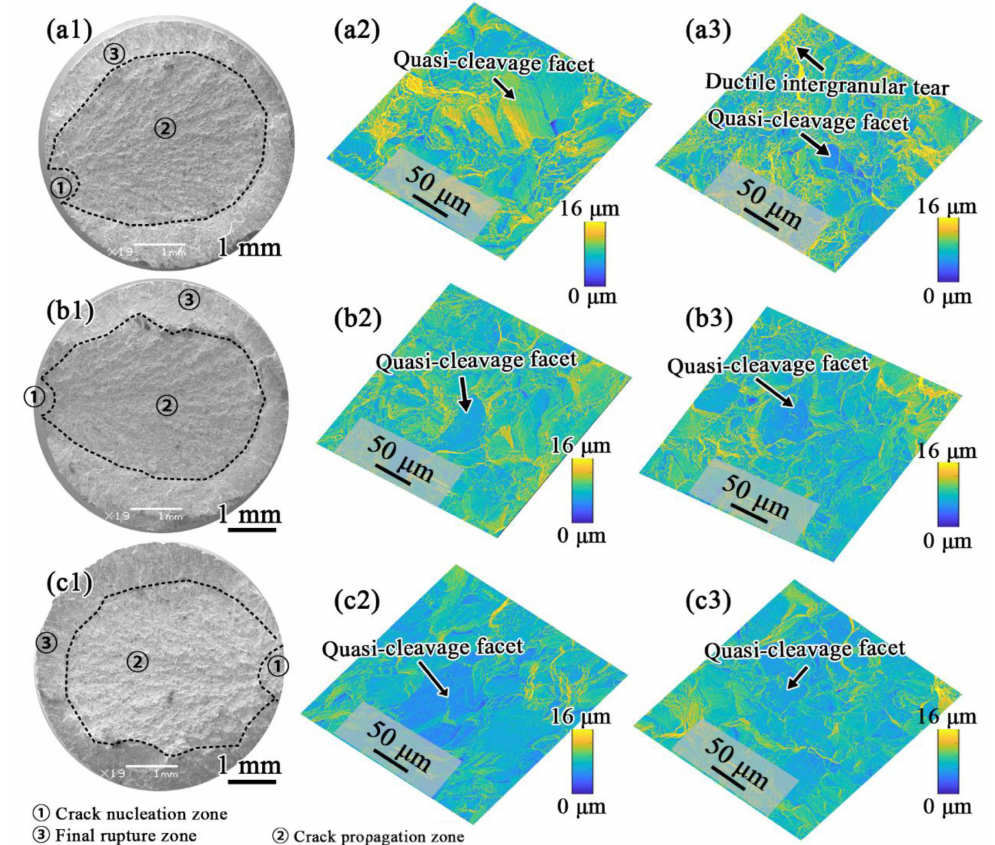
Figure 10. Fractographies of 650 ◦ C tensile specimens of ( a1 ) HT-1, ( b1 ) HT-2 and ( c1 ) HT-3, and height contour coloring maps in middle column of ( a2 ), ( b2 ), ( c2 ) correspond to crack nucleation zones, and these in right column of ( a3 ), ( b3 ), ( c3 ) correspond to propagation